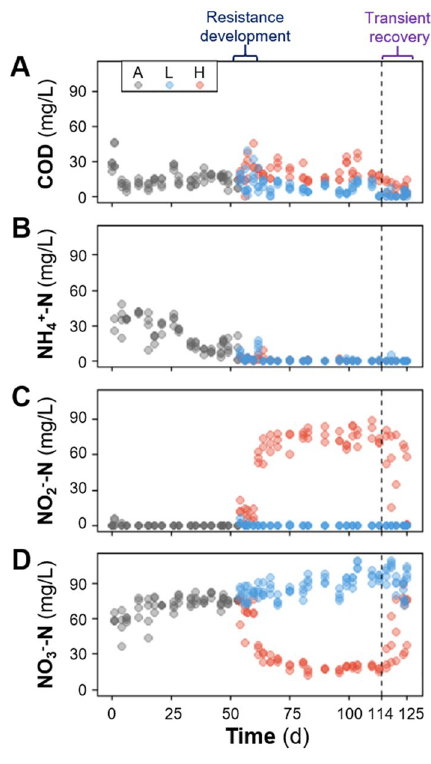
Figure 2. Temporal average effluent concentrations in mg/L of ( A ) soluble COD, ( B ) NH 4+ -N, ( C ) NO 2– -N and ( D ) NO 3– -N. Phases: A, acclimation (n = 4); L, low F:M–C:N (n = 4); H, high F:M–C:N (n = 3). Vertical dashed line indicates the shift from high to low F:M–C:N. Periods of functional resistance development and transient recovery are indicated by curly